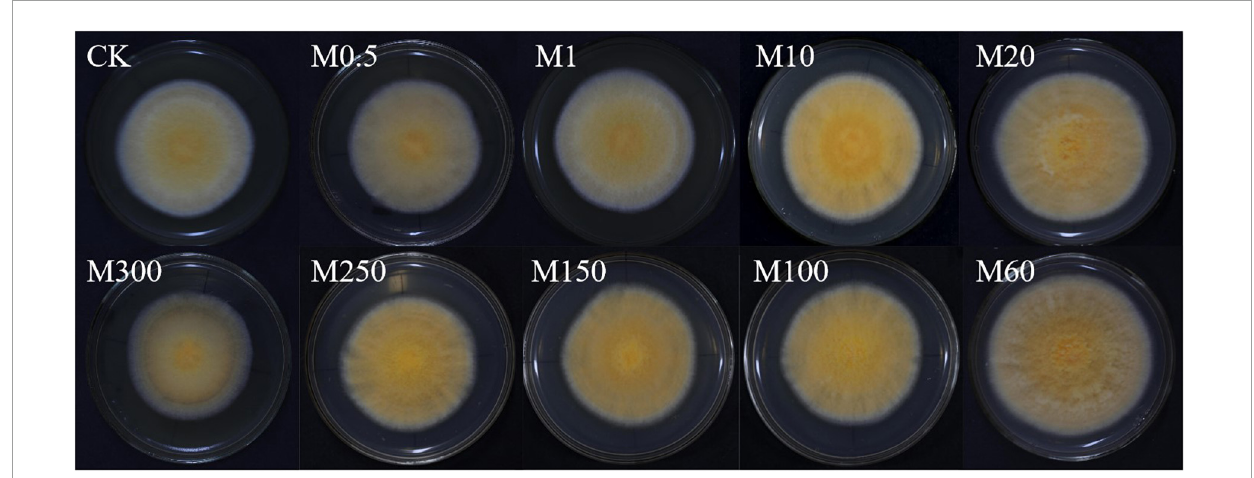
FIGURE1 Effects of MT on colony morphology and C. militaris mycelial growth. Bar, 90 mm. The experiment was repeated ten times. A representative picture is shown here. M0.5, add 0.5 µ mol L − 1 of MT; M1, add 1 µ mol L − 1 of MT; M10, add 10 µ mol L − 1 of MT; M20, add 20 µ mol L − 1 of MT; M60, add